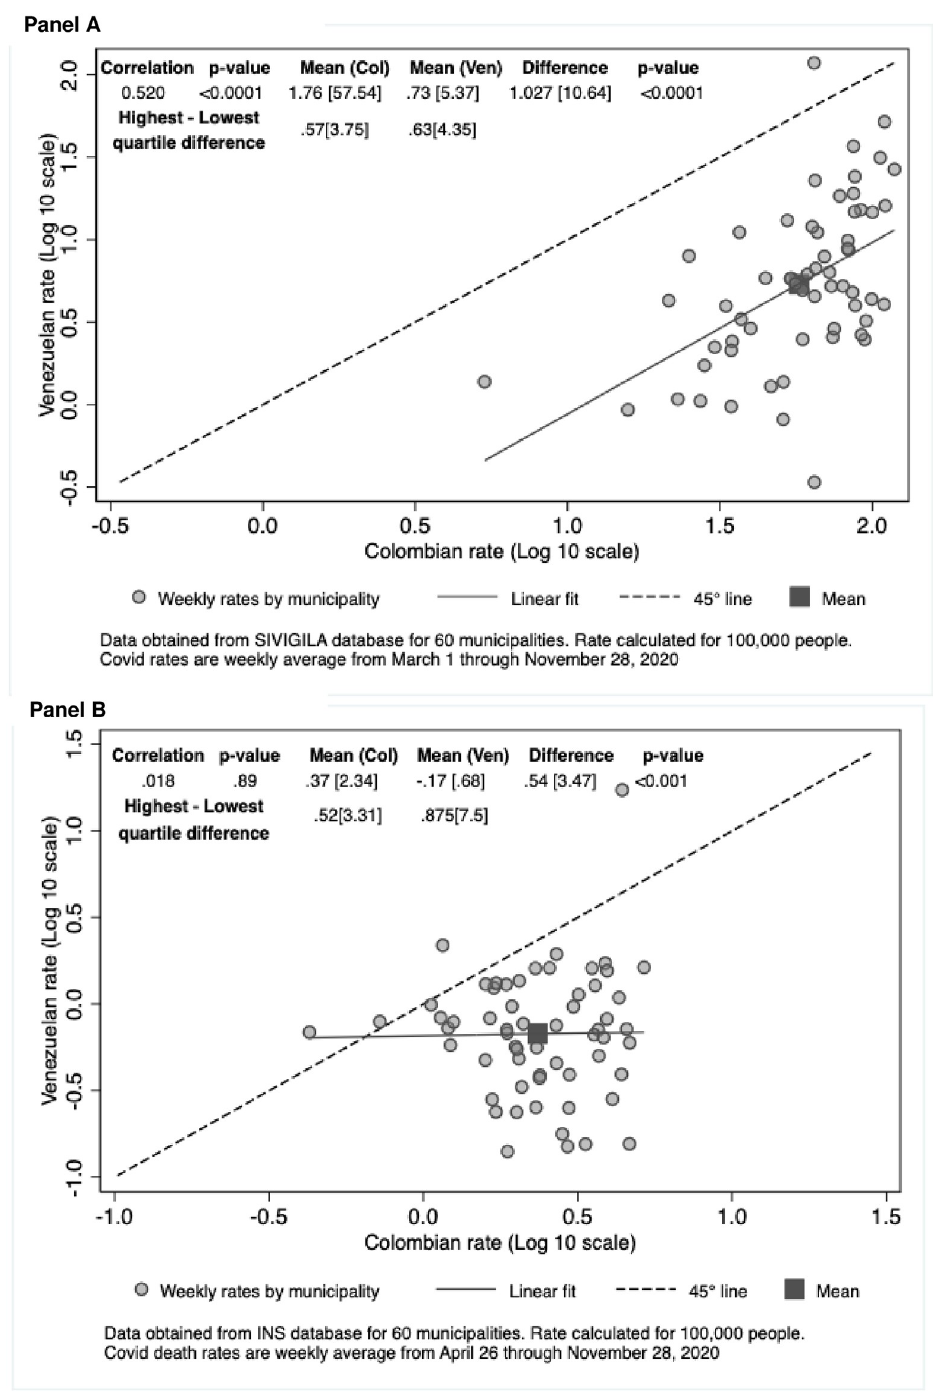
Fig 2. Venezuelan versus Colombian COVID-19 rates per 100,000 population in 2020 by municipality in (A) cases and (B) deaths.